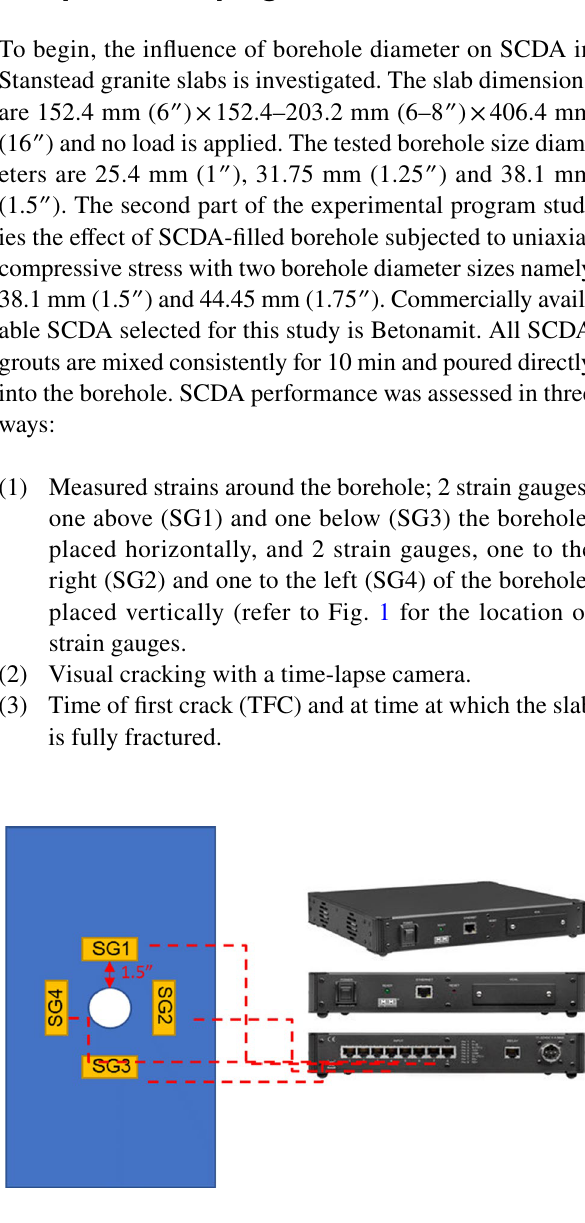
Fig. 1 Location of strain